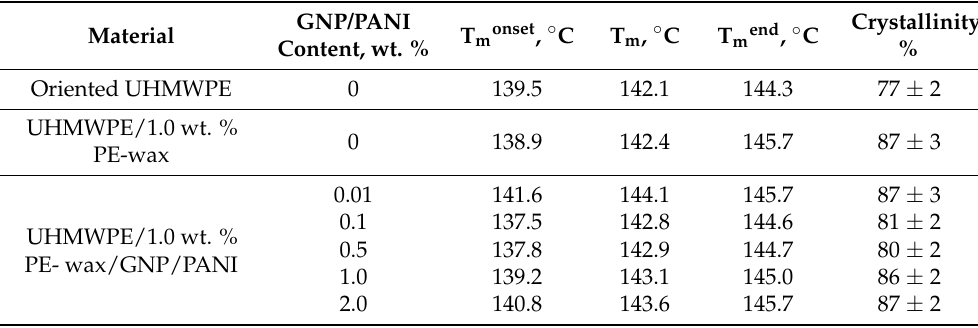
Table 5. DSC test results for the UHMWPE/1.0 wt. % PE-wax/GNP/PANI films obtained by first thermal orientation regime ( ± the standard deviation).